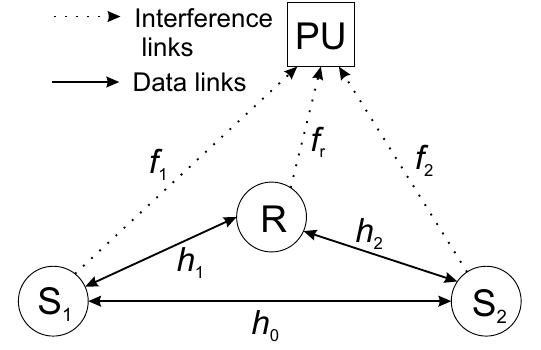
Figure 1. Two-way relaying in cognitive cooperative communica-